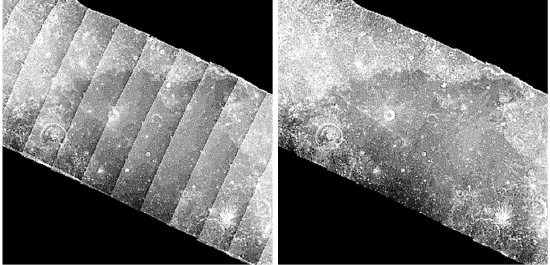
Figure 8: Cosmetic methods to minimize variation in tone, brightness, and shadows were applied within each orbit. Left: controlled raw image mosaic. Right: after adjustment, seams are notably less visible and tone more uniform. Area shown is from nadir orbit 16 centered at 2.0°N,